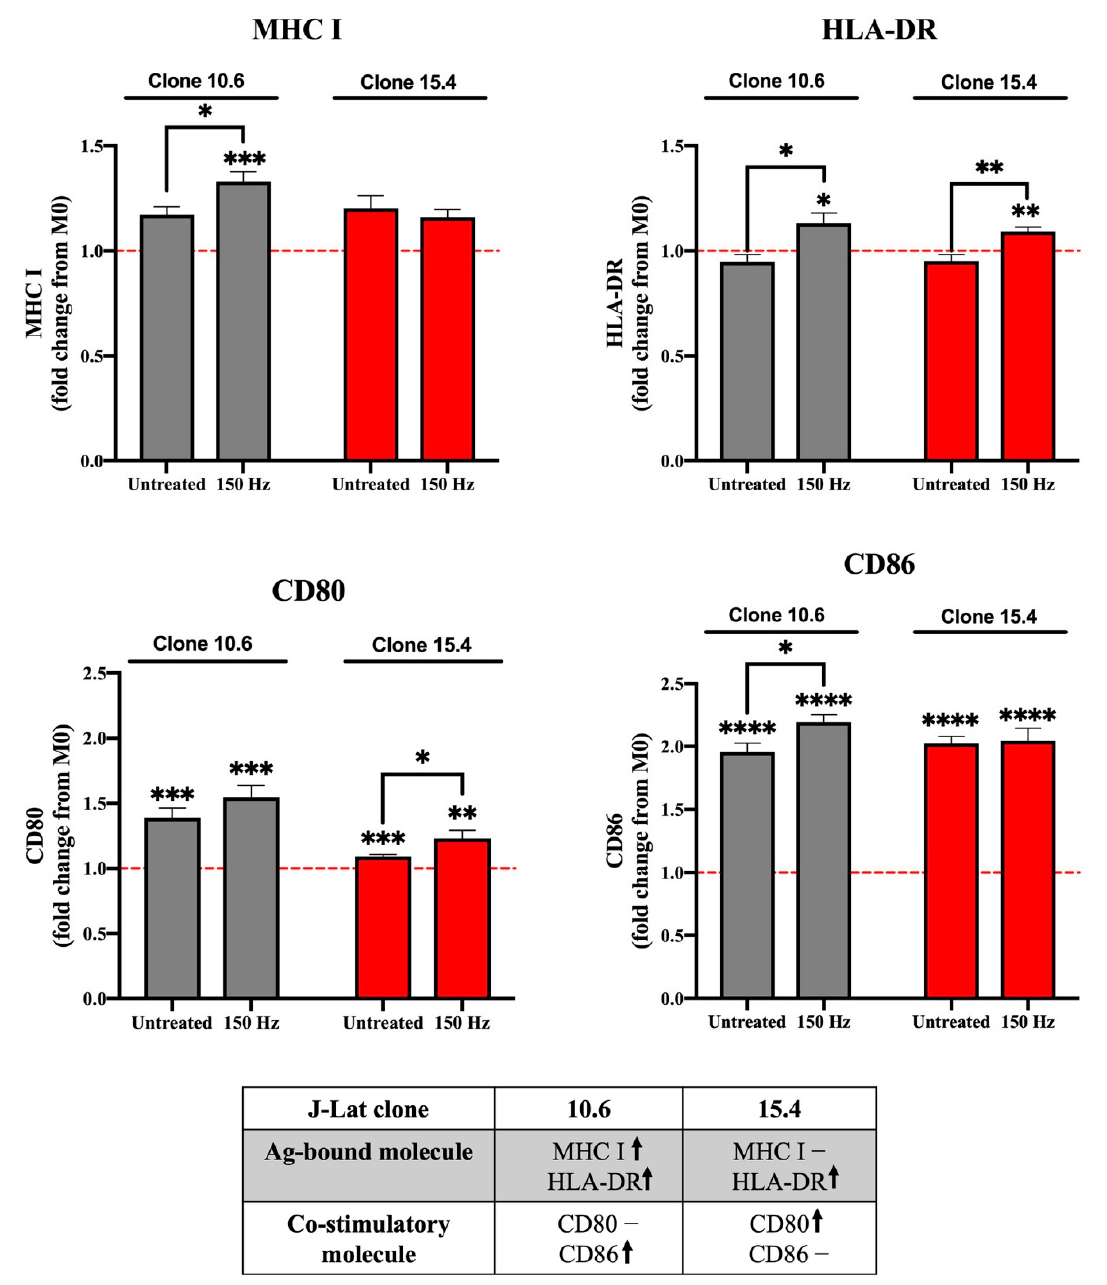
Figure 2. Phagocytic uptake of NTP-exposed J-Lat clones promotes maturation of M0 macrophages. M0 macrophages that engulf NTP-exposed (150 Hz for 10 s) J-Lat cells (gray, clone 10.6; red, clone 15.4) have altered expression of maturation markers MHC I, HLA-DR (MHC II), CD80, and/or CD86. The red dotted line in each graph indicates no change with respect to M0 macrophages cultured without J-Lat cells. The table summarizes changes in expression in the antigen (Ag)-presenting molecule or co-stimulatory molecule on macrophages that engulfed NTP-exposed J-Lat cells relative to M0 macrophages cultured alone ( ↑ and – indicate an increase and no change, respectively). Data are presented as mean ± SEM from four independent experiments, with three replicates per condition in each of the three experiments. Statistical significance was calculated using a Brown–Forsythe and Welch’s Anova test, by comparing the mean fluorescence intensity (MFI) of MHC I, HLA-DR, CD80, or CD86 on matured macrophages to M0 macrophages cultured in the absence of J-Lat cells (* p ≤ 0.05, ** p < 0.01 *** p < 0.001, **** p < 0.0001).